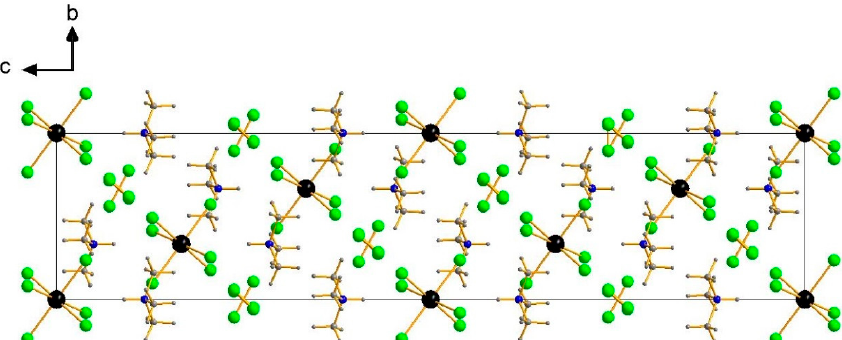
Figure 2. Crystal packing in the structures of 1 and 2 . C and H: grey, N: deep blue, metal: black, Cl: light green.